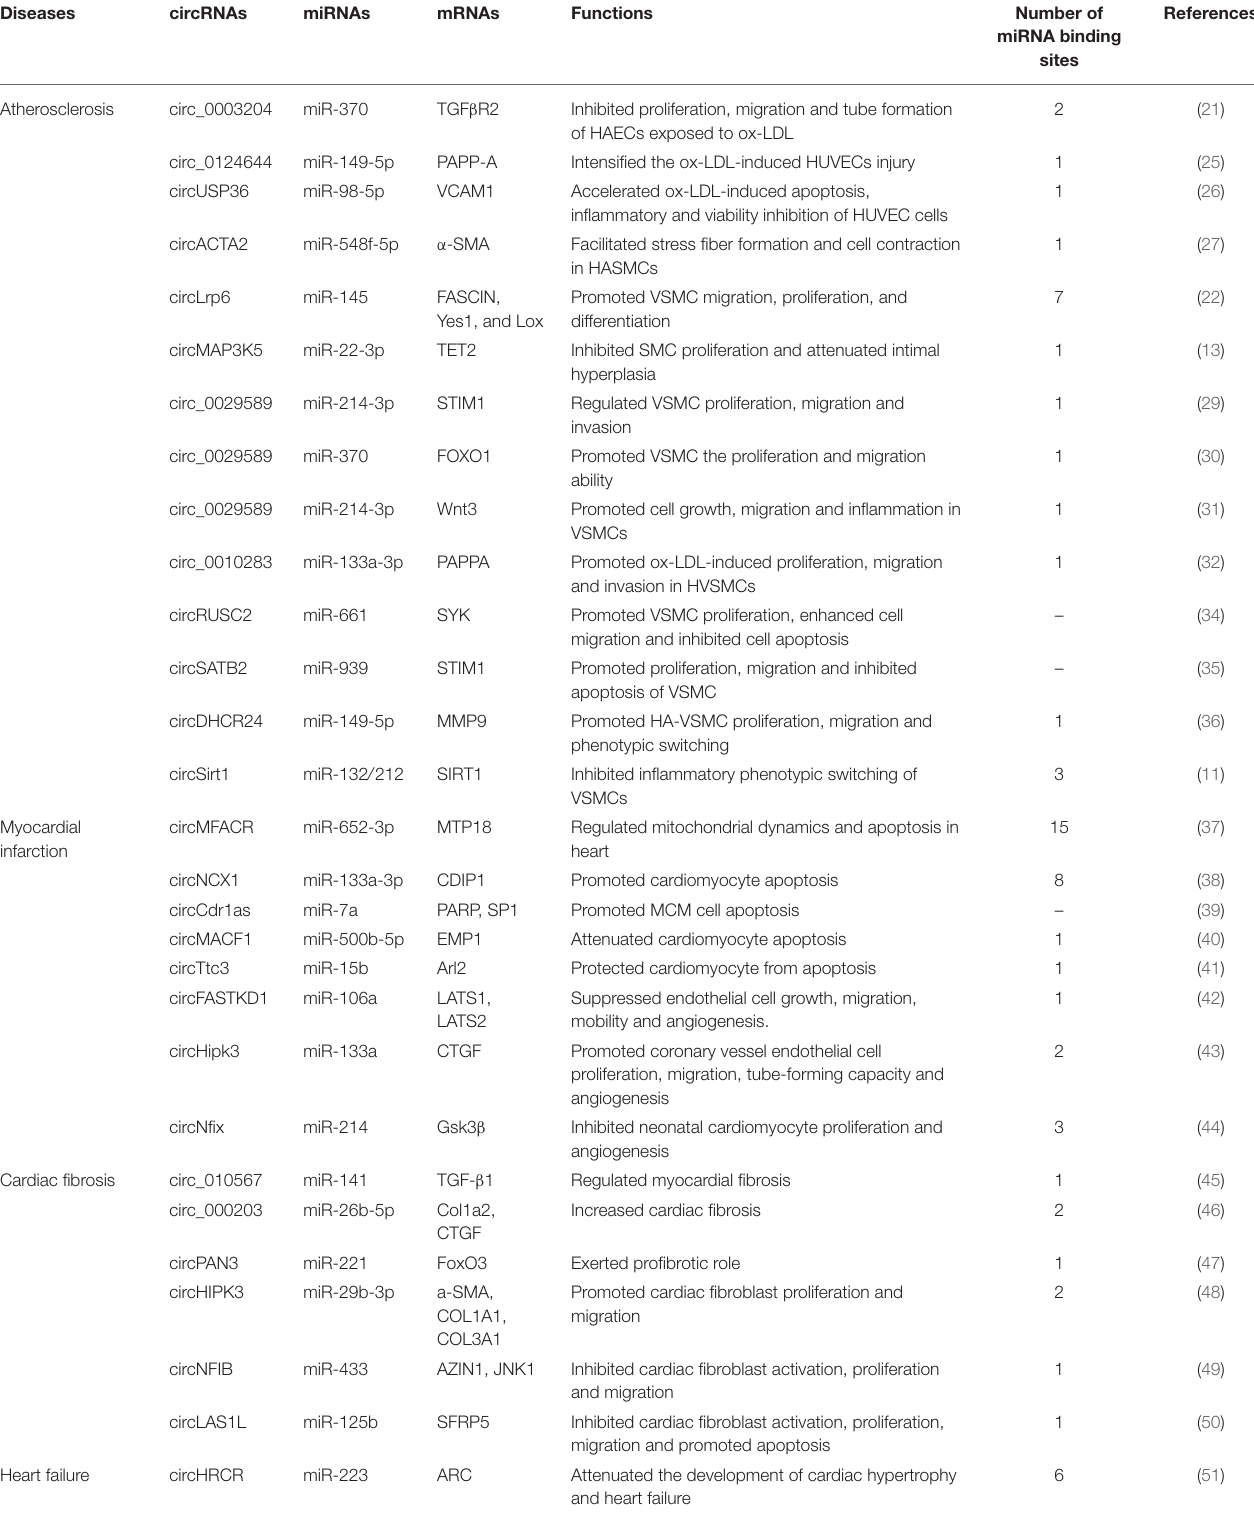
TABLE 1 | CircRNAs as ceRNAs in